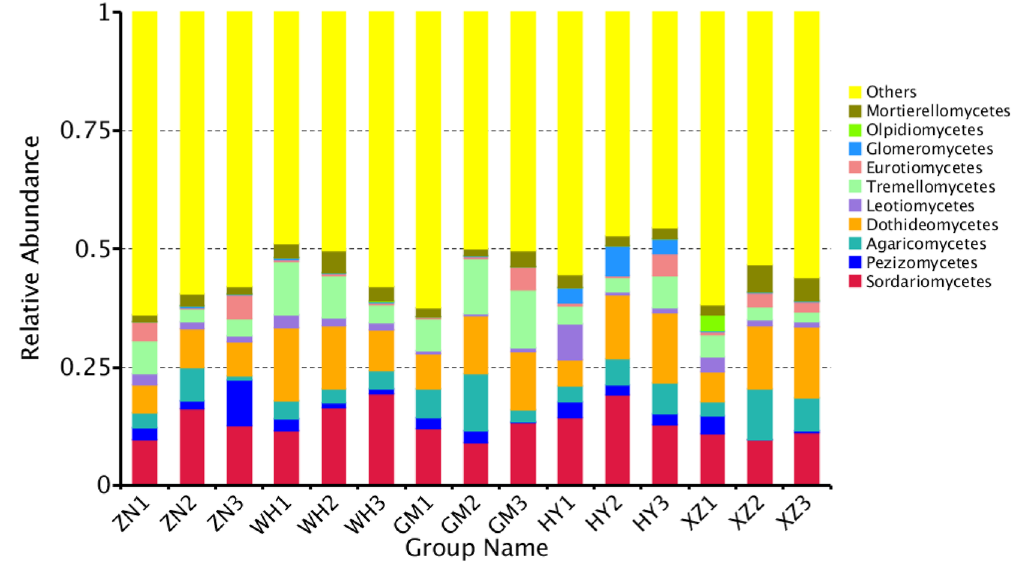
Figure 3. Relative abundance of top 10 fungal classes. Figure 2 shows the relative abundance of top 10 fungal phyla in grape rhizosphere soil, and Fig. 3 shows the relative abundance of top ten fungal classes in grape rhizosphere soil. The abbreviations ZN, XZ, HY, WH, GM represent the grape planting years of 5, 8, 10, 12 and 15, respectively; and the numbers 1, 2 and 3 represent the rhizosphere soil depths of 5–20, 20–35 and 35–50 cm,